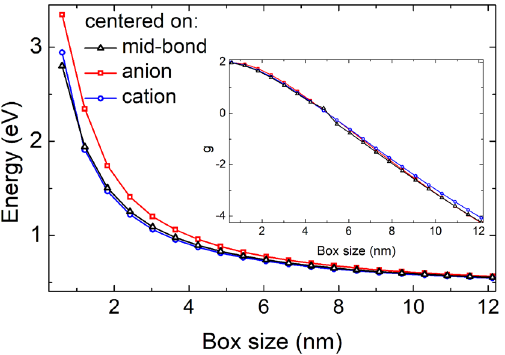
Figure 4. (Color online) The ground electron state energy as a function of box size for different choice of origin, i.e. centered on anion, cation, and mid-bond respectively. Inset shows corresponding values of electron g -factor. See text for